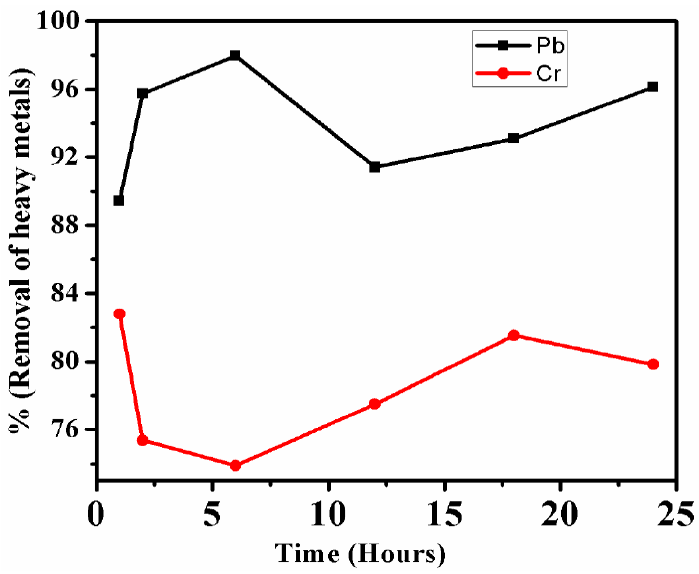
Figure 9. Pb and Cd removal from fly ash aqueous solution by IONPs.